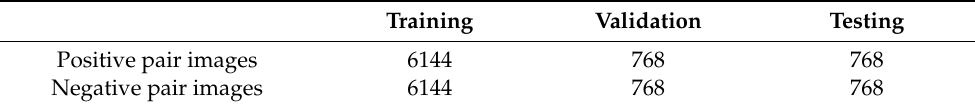
Table 5. Number of pairs of images used for training, validation, and test in the damage detection model.